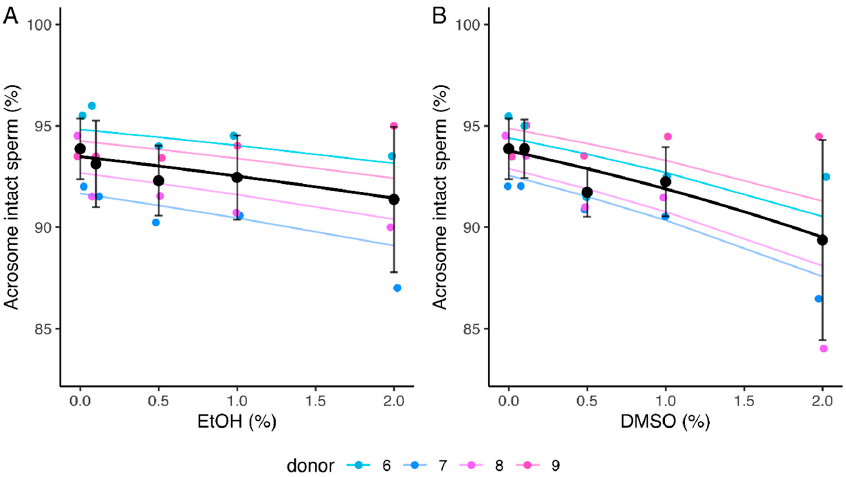
Figure 5. Influence of ethanol (EtOH) ( A ) and dimethyl sulfoxide (DMSO) ( B ) on sperm acrosome integrity after a 4 h incubation. Values for each replicate ( n = 4) are highlighted by a dot whose color refers to a donor. Colored lines represent the model fit for each donor. Black dots represent mean values for each concentration ± SD. Black lines correspond to the mean effect across all donors (Tables 2 and S3).